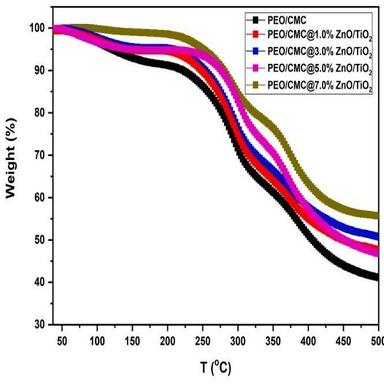
TGA thermograms of polymer blend with and without different concentrations of zinc oxide/titanium dioxide nanoparticles.